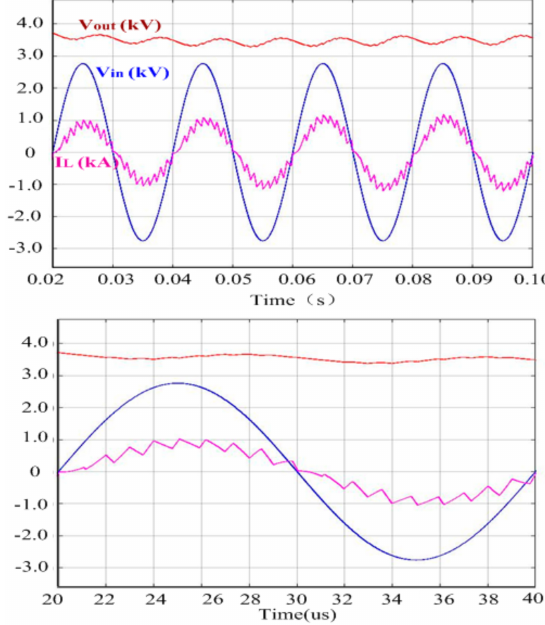
Figure 15. Simulation of the single PWM rectifier with an